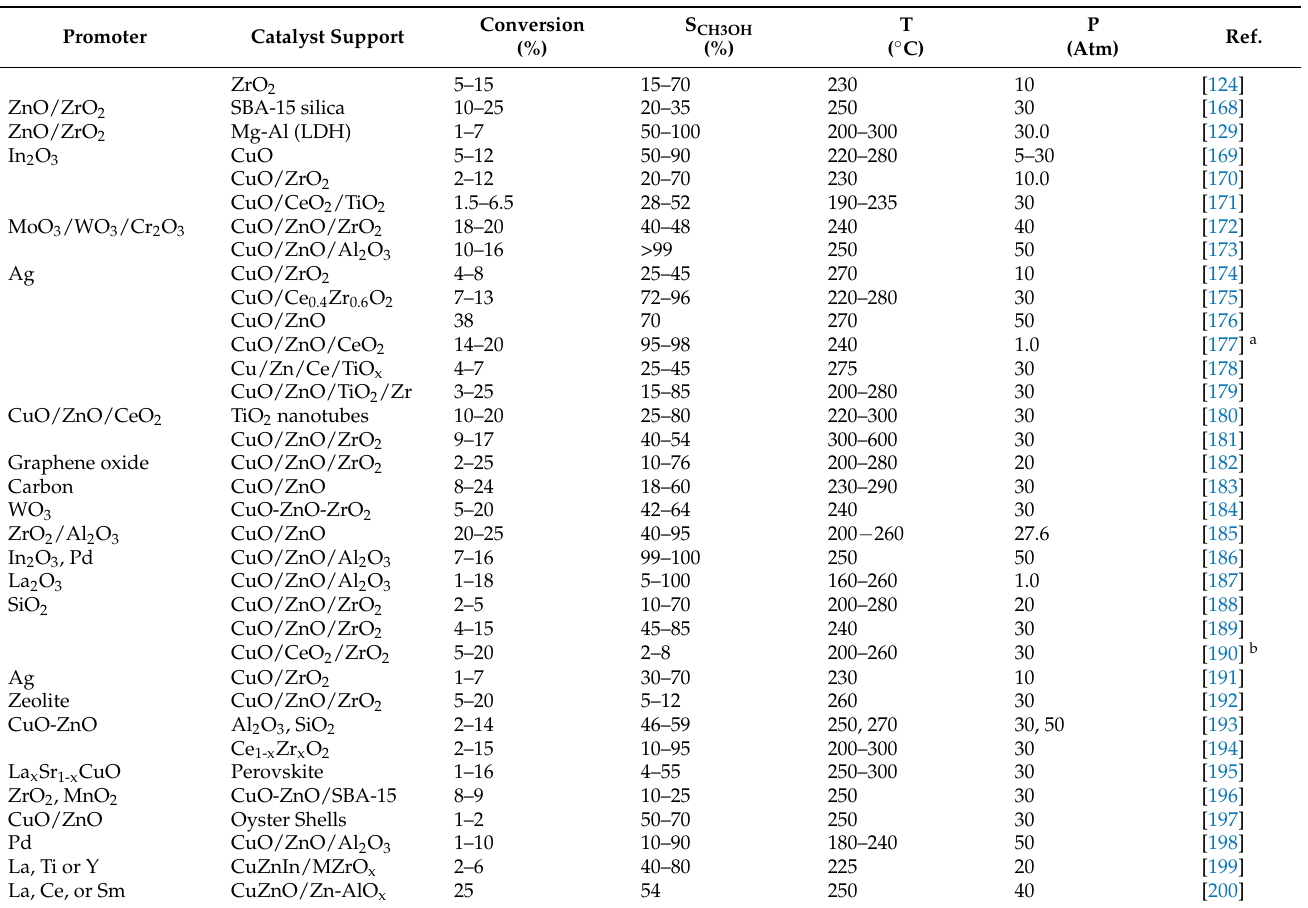
Table 5. Comparative performance in the carbon dioxide hydrogenation to methanol reaction, of different CuO supported catalysts, using different solid as supports, different synthesis methods or different